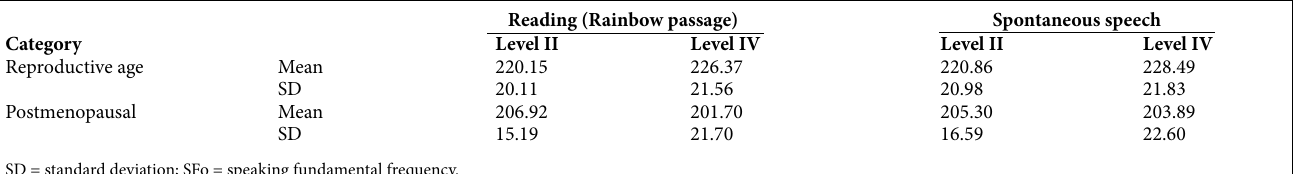
values (in Hz) for reading and spontaneous speech tasks across the different o Reading (Rainbow passage)